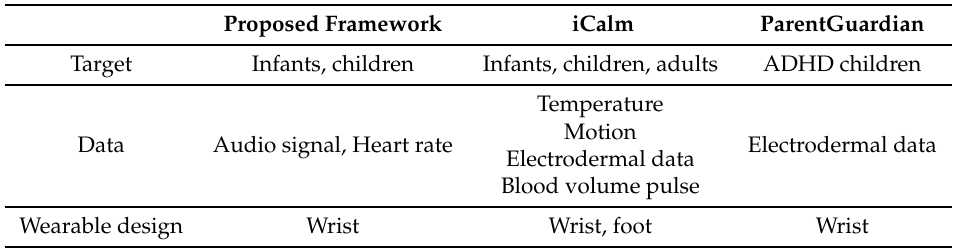
Table 2. Summary of the commercial stress detection devices in terms of their target, utilized data, and wearable design.